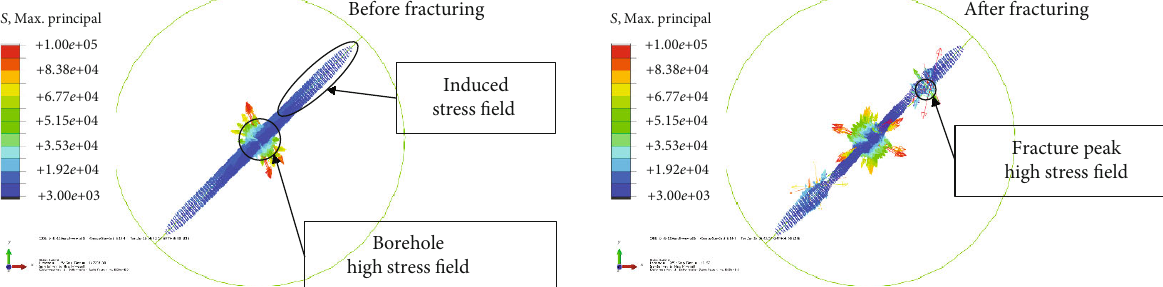
Figure 5: Stress direction diagram of induced stress fi